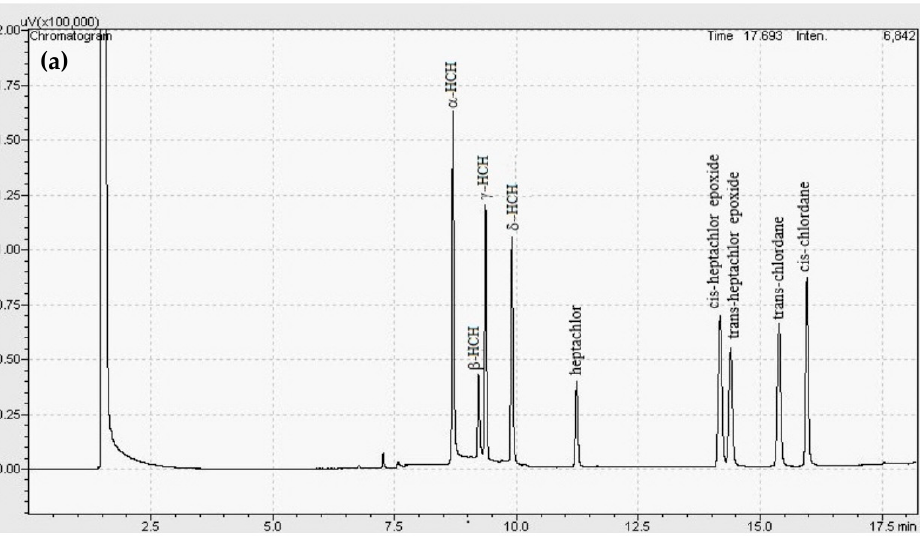
Figure 3. Selectivity chromatogram of the organochlorine compounds standards ( a ) 0.1 µg mL − 1 in ACN and ( b ) 100 µg kg − 1 in soil matrix. * Indicates some contaminant non-identified from the soil matrix. Figure 4. Analytical curves of α -HCH in ACN solvent and soil